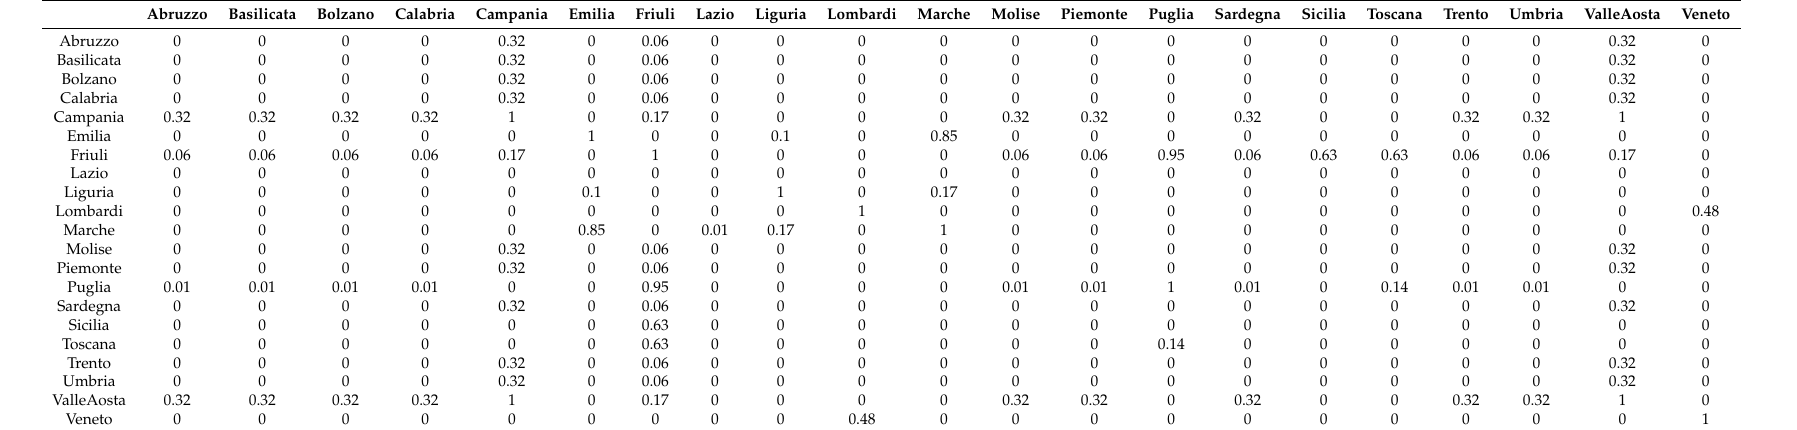
Table A39. Similarity values of Discharged/Healed network in the second week.